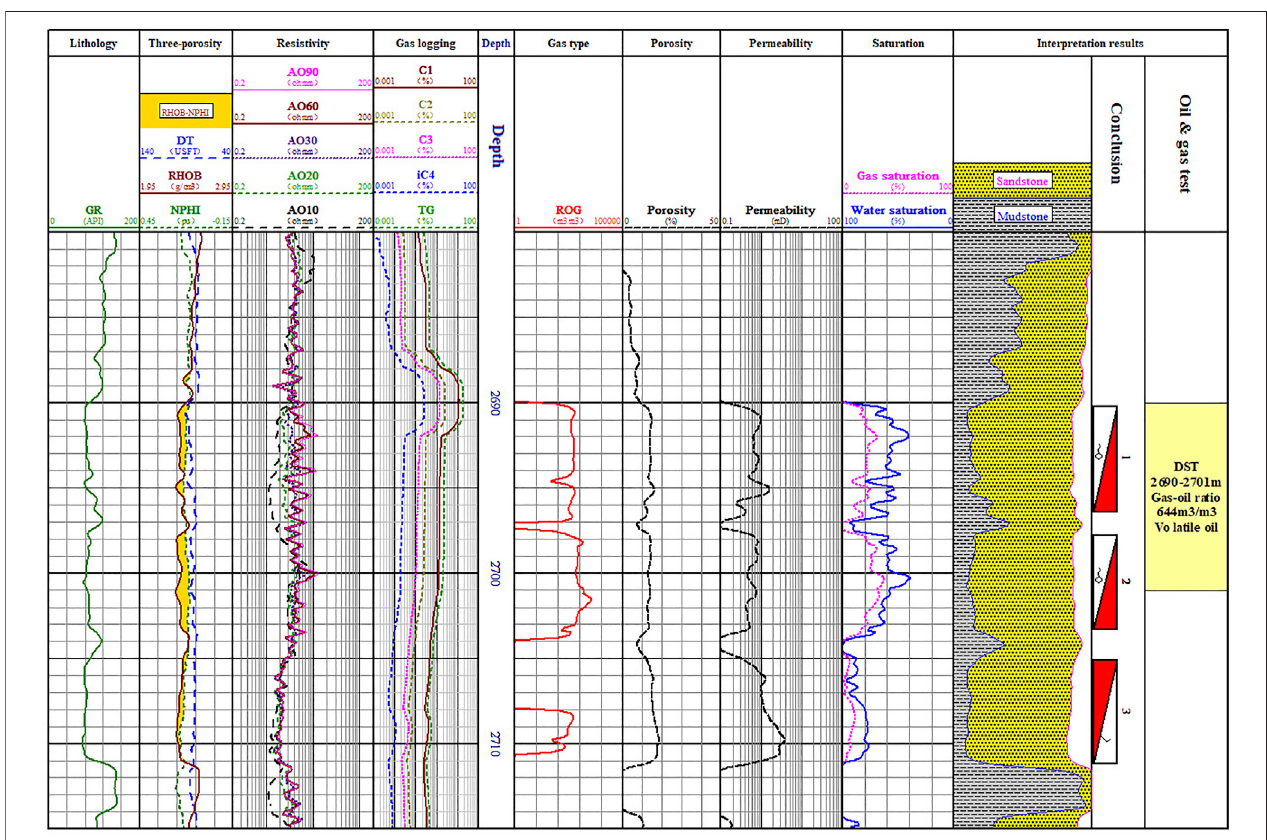
FIGURE 8 | Diagram of the logging interpretation results of well W-3-1 (2680 – 2713 m).